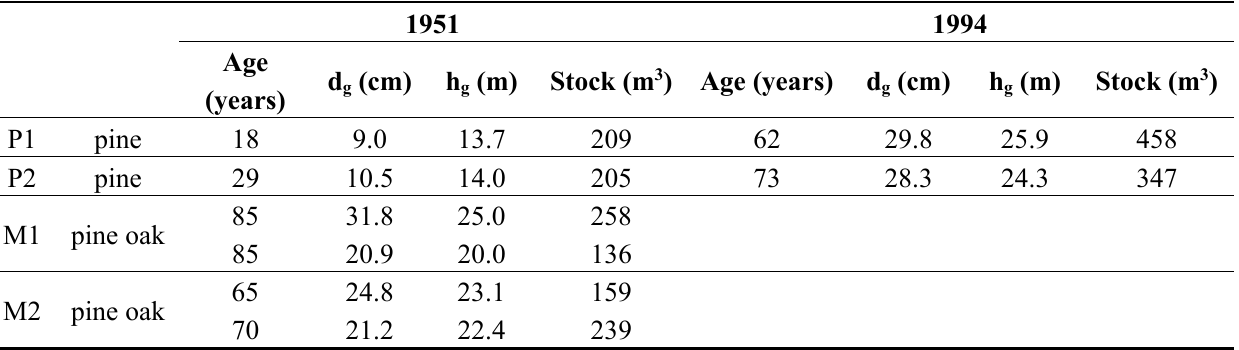
Table 1. Stand data for initialization in 1951 and 1994, respectively (d g = mean tree diameter at breast height, h g = mean tree height).